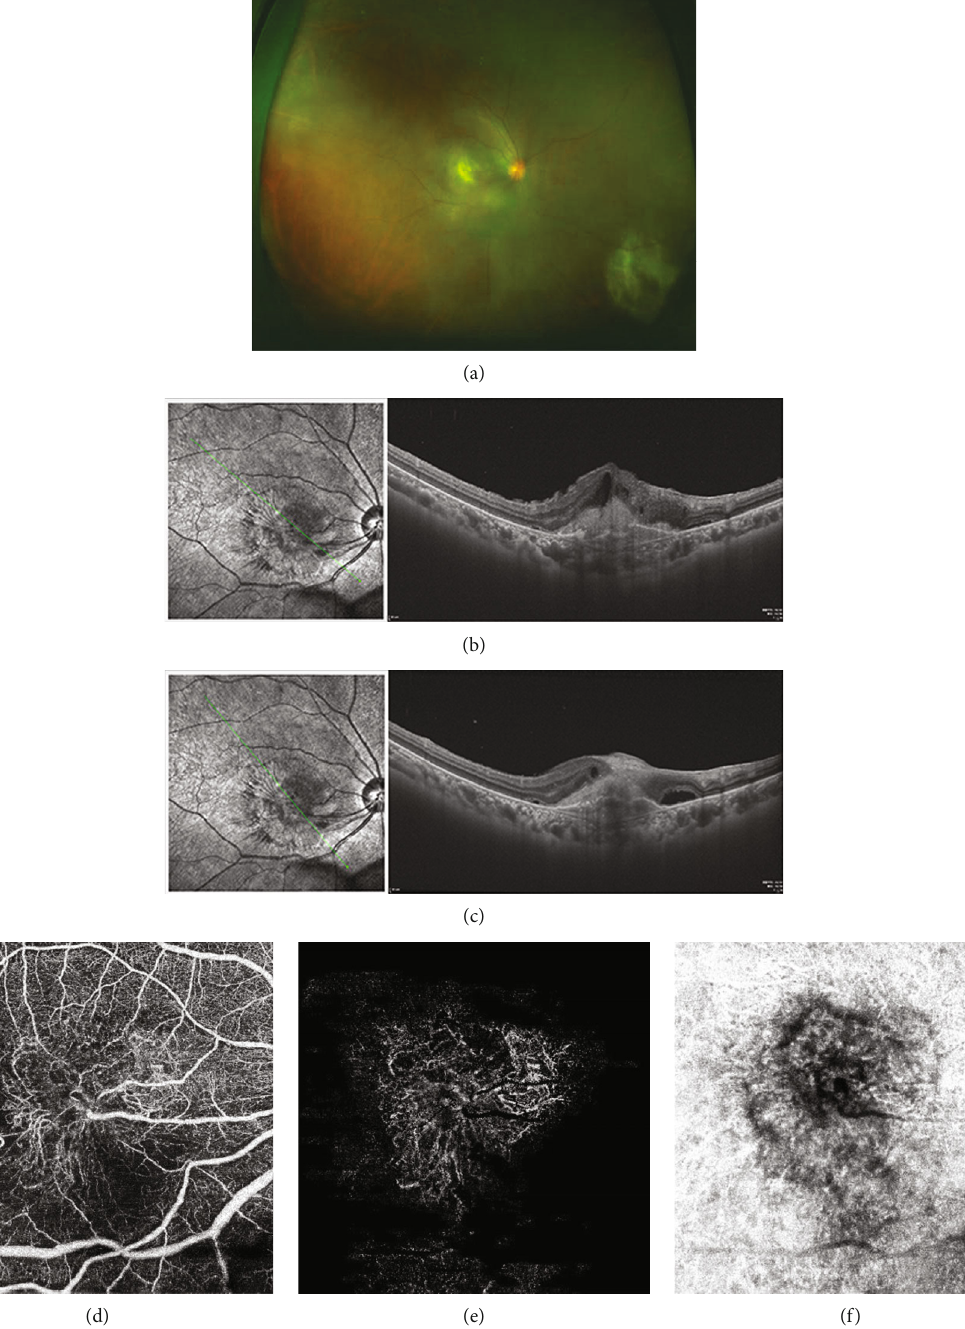
Figure 3: The deterioration of RAP in the right eye. (a) In fl ammatory cells in the vitreous cavity disappeared and fundus can be seen clearly. (b) The central retinal thickness increased; intra- and subretinal fl uid produced. (c) OCTA showed the area of abnormal vascular network in the inner retina (d) and outer retina (e), and choroid layers (f) were